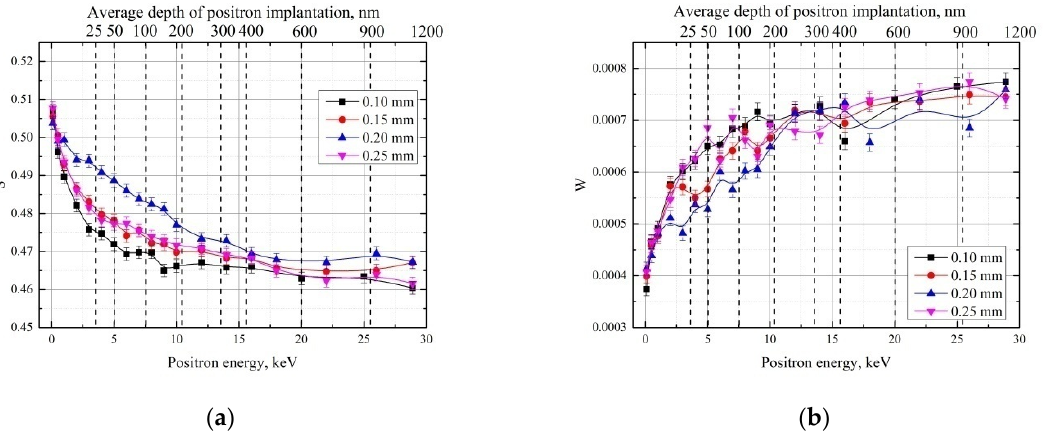
Figure 8. DBS-VEP depth profile of the S ( a ) and W ( b ) parameters for the white layer in GCr15 steel samples with different cutting depths.